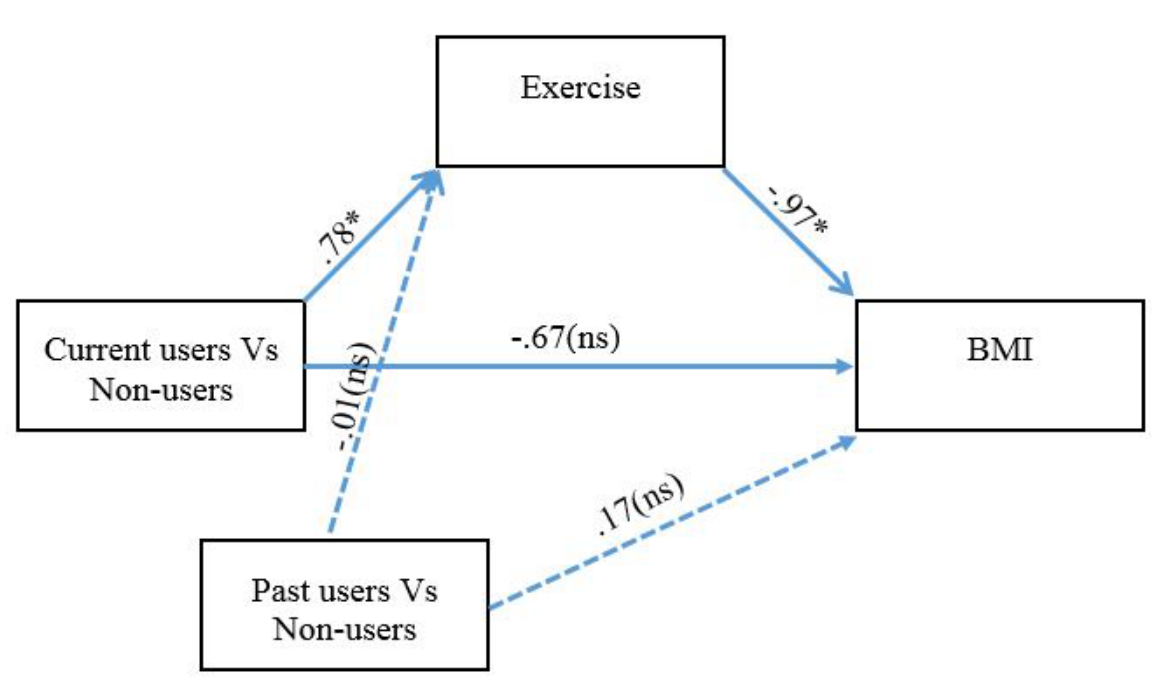
Figure 3. Mediation model in which app use was modeled as a 3-level predictor categorical variable in two separate contrasts. Solid lines depict the indirect and direct effects of a 2-level current users vs non-users contrast’s effect on BMI. The dashed lines depict the indirect and direct effects effect of a 2-level past users vs non-users contrast’s effect on BMI. Asterisk indicates significant results at P <.05 level. ns indicates non-significant results at the P <.05